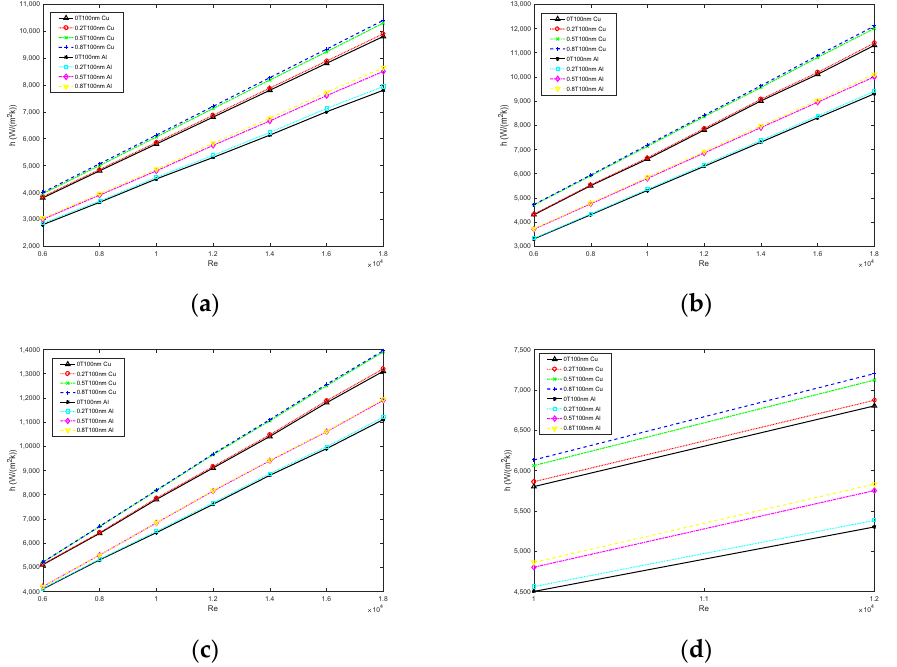
Figure 7. The heat transfer coefficients of the Cu-H 2 O and Al-H 2 O nanofluids flow varied with different Reynolds numbers. The magnetic fields were applied along the Z direction, and the intensities of magnetic fields were 0.2 T, 0.5 T, and 0.8 T. The volume fractions of nanoparticles were 0.5% ( a ), 1% ( b ), and 2% ( c ). ( d ) Zoom in ( a ) for detail on when Re were 10,000 and 12,000.